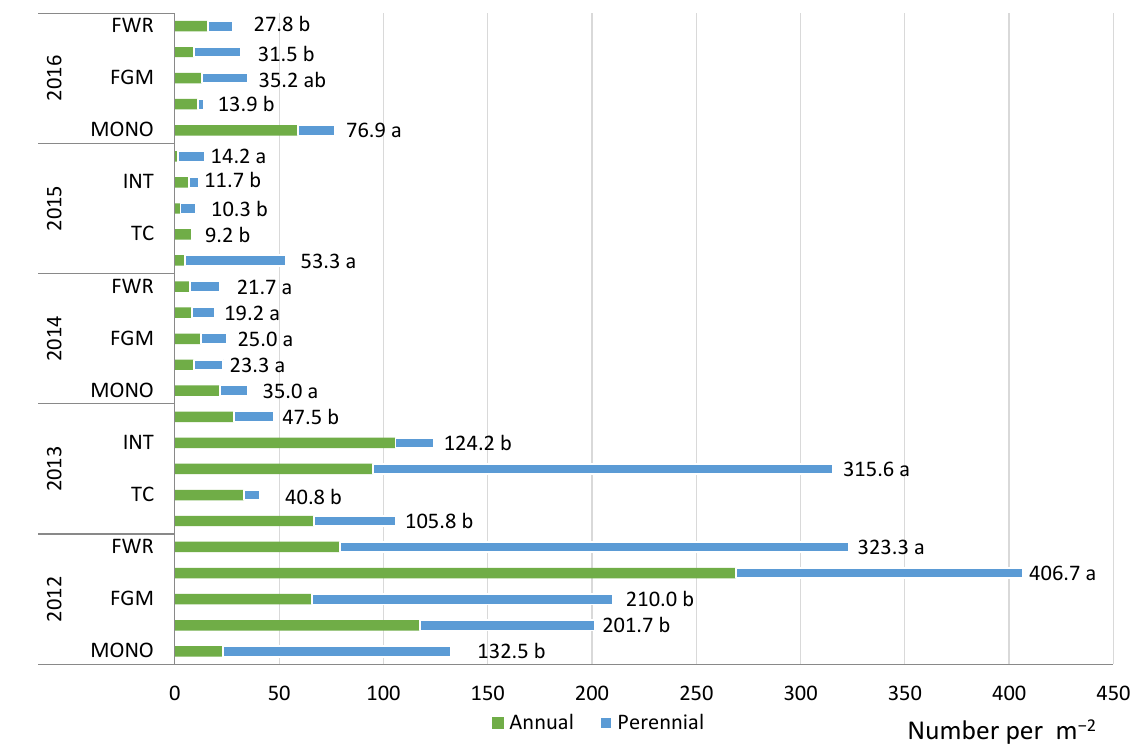
Figure 2. The number of annual and perennial weeds per m − 2 in winter rye stands before harvesting in 2012–2016. Note: different letters indicate significant differences between the treatments ( p ≤ 0.05); FWR—field rotation with row crops;